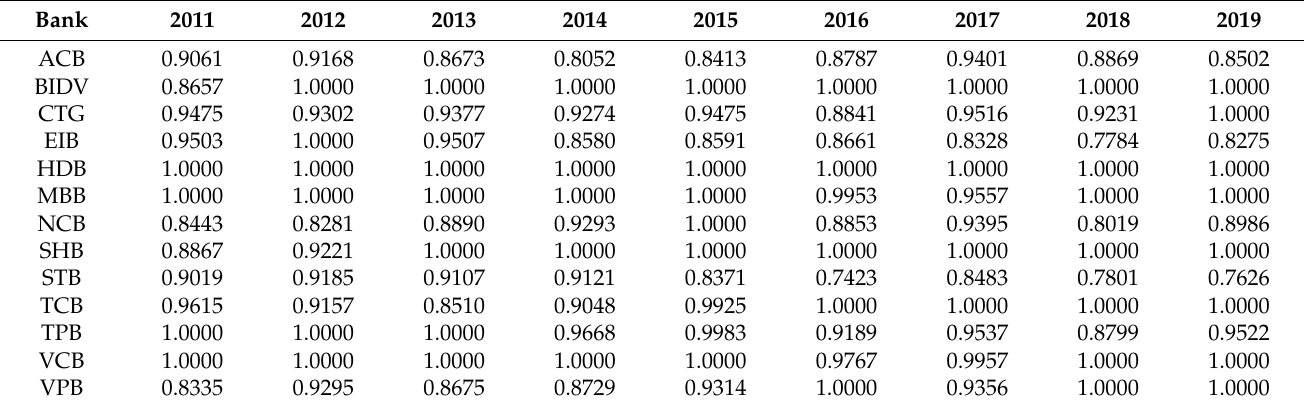
Table 1. The result of DEA analysis of commercial banks’ performance.